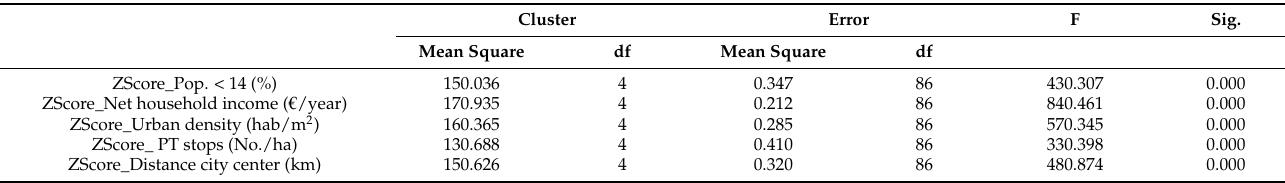
Table A2. ANOVA analysis results from the k-means procedure.